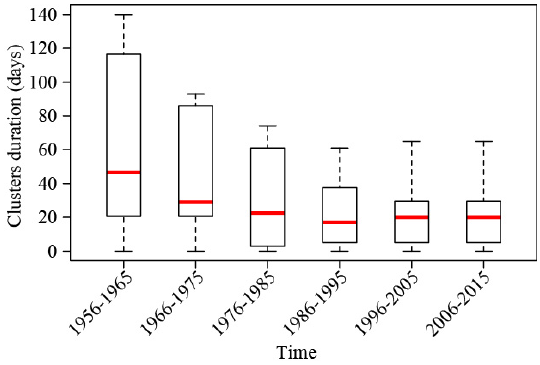
Figure 9. Boxplots summarizing the descriptive statistics of the du- ration of clusters reported in Fig.